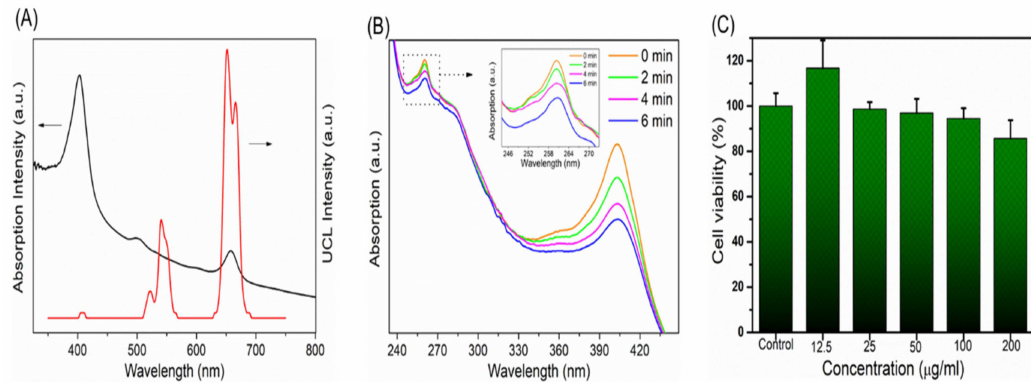
Figure 3. ( A ) Absorption spectrum and the upconversion spectrum of NaYF 4 :Yb 3 + ,Er 3 + @Ce6@silane. Red emission region overlaps the absorption band of Ce6 molecules. ( B ) Generation of singlet oxygen generation under 980 nm irradiation. ( C ) Dark cytotoxicity of NaYF 4 :Yb 3 + ,Er 3 + @Ce6@silane NPs on mouse fibroblast cell line L929: Viability of L929 cells vs. concentration of NaYF 4 :Yb 3 + ,Er 3 + @Ce6@silane NPs after 24 h without irradiation in the dark (mean ±